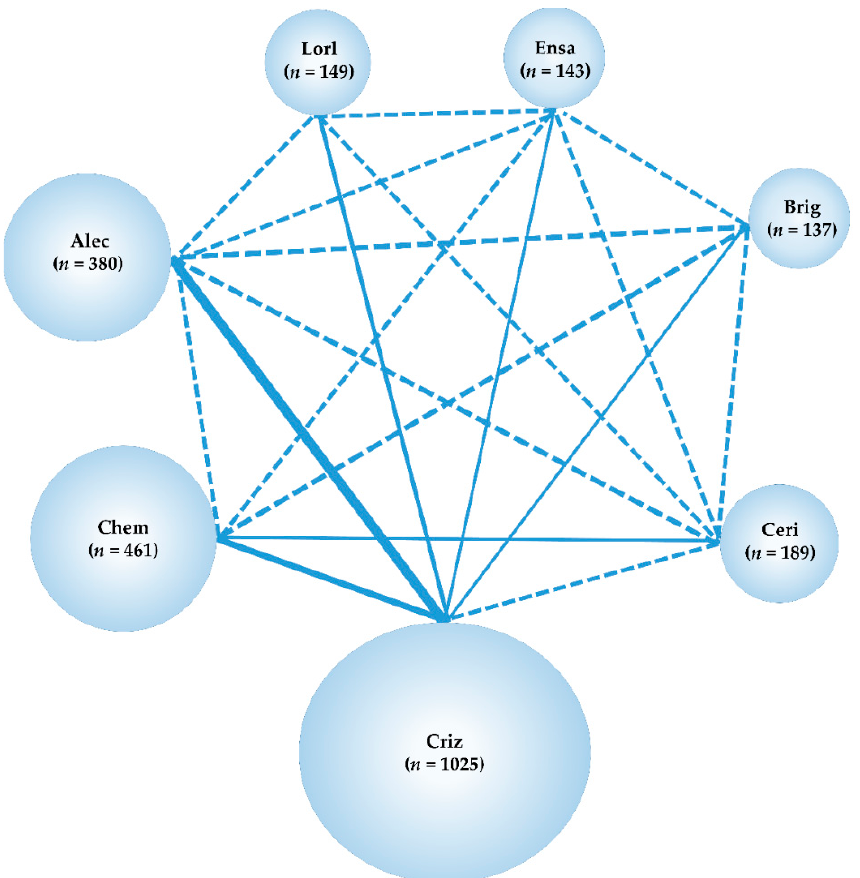
Figure 4. Network map of the seven therapeutic groups: ensartinib, lorlatinib, brigatinib, alectinib, ceritinib, crizotinib, and chemotherapy. In this network map randomized controlled trials (RCTs) were represented by a solid line, with the breadth of the solid line correlated with the numbers of studies included. Broken lines represent no head-to-head RCTs and trial to comparison of treatments. n is the total number of patients in each group; Ensa, ensartinib; Lorl, lorlatinib; Brig, brigatinib; Alec, alectinib; Criz, crizotinib; Ceri, ceritinib; Chem, chemotherapy.